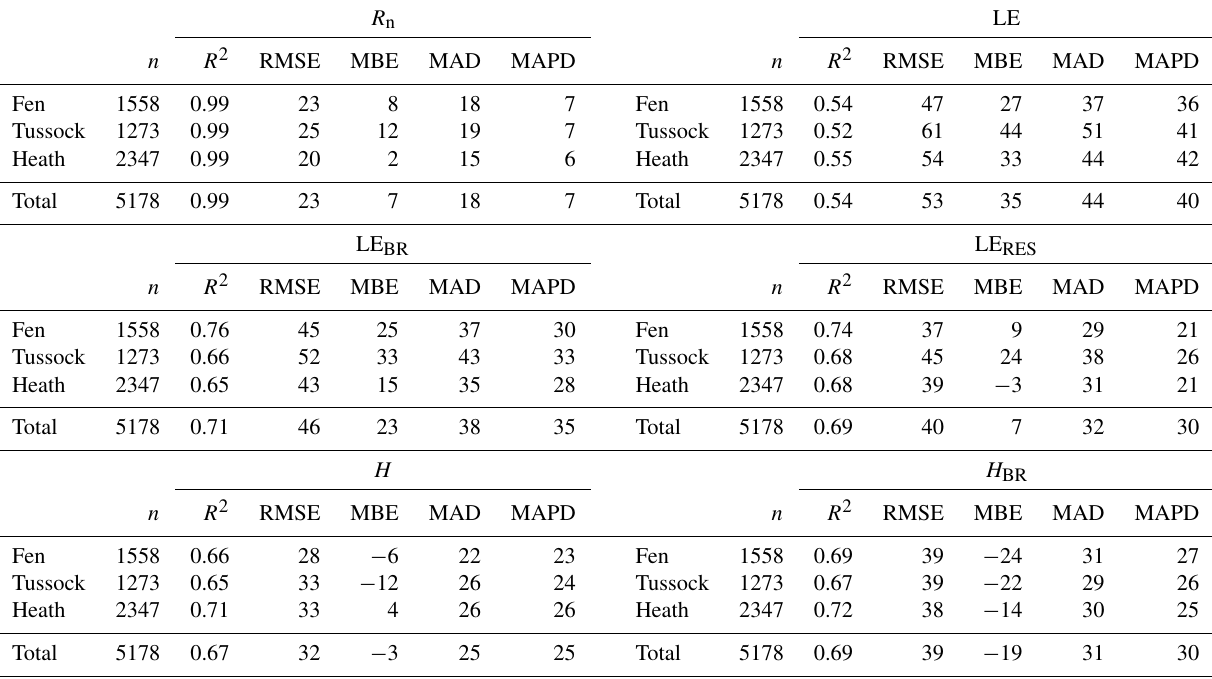
Table 5. Accuracy and error statistics from the comparison of modeled vs. observed unclosed and closed surface fluxes using α PTC of 0.92. n is the number of half-hour periods analyzed. RMSE, MAD and MBE are in Wm − 2 and MAPD is in %.